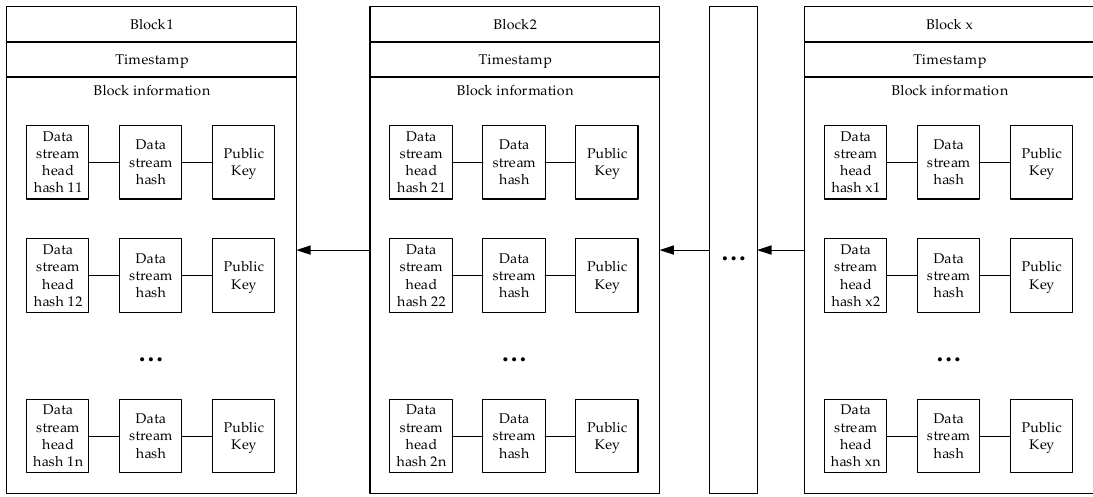
Figure 5. The structure of the data storage model based on the blockchain .